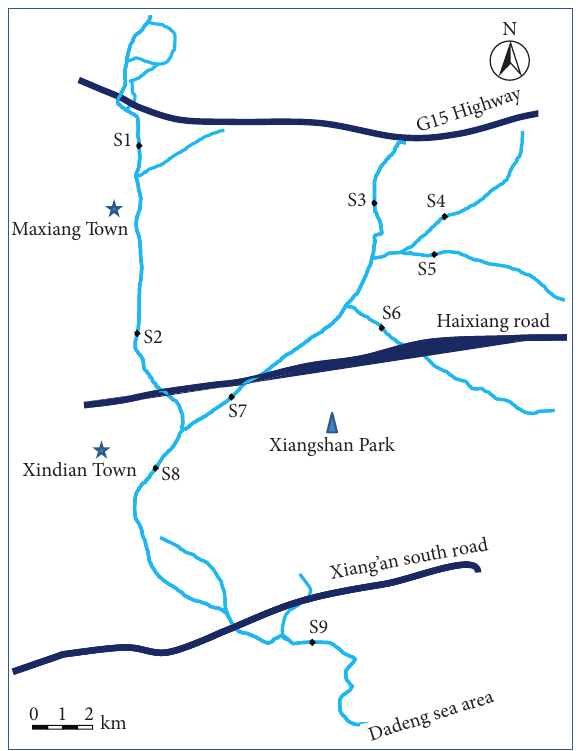
Figure 1: Sampling points of the Jiuxi Valley,